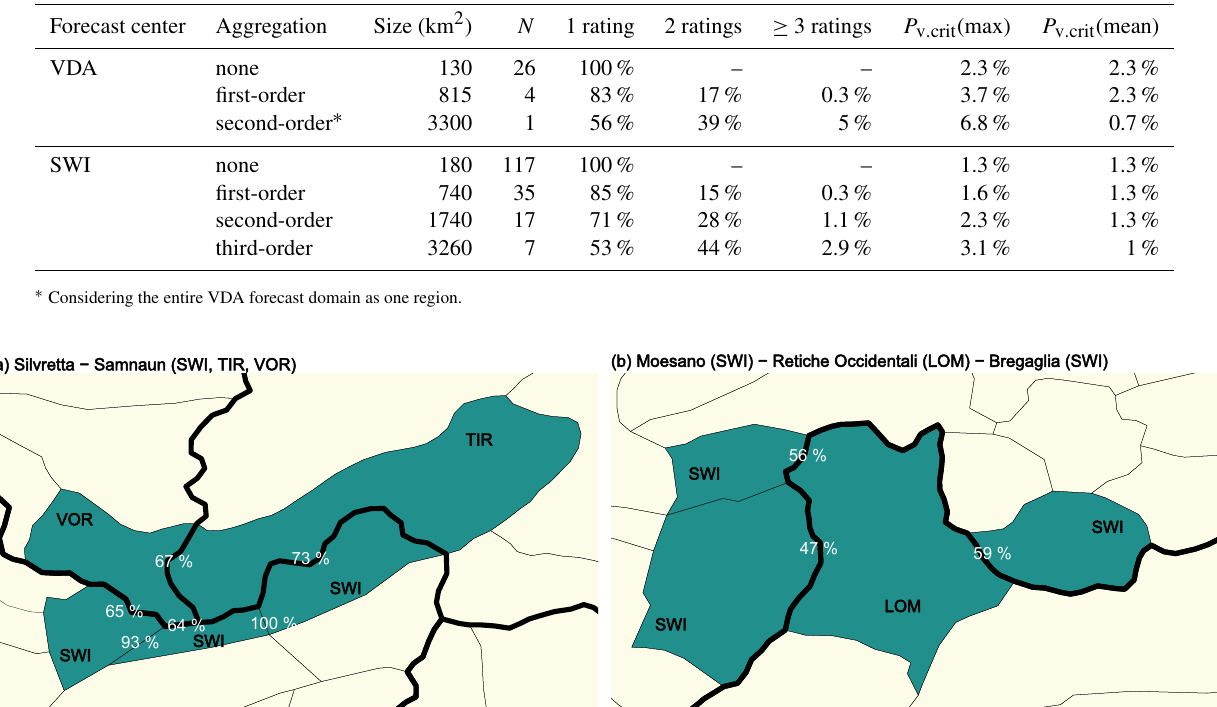
Table 6. Variability in danger ratings and the proportion of forecasts with danger levels 4 – high or 5 – very high ( P v . crit ) assuming different aggregation levels as the given spatial resolution for danger level communication. The aggregation level none indicates the currently used spatial resolution. The aggregated median size and number ( N ) of regions within the forecast domain are indicated. P v . crit (max) assumes the communication of the highest danger rating per region, and P v . crit (mean) the spatially most relevant danger rating.